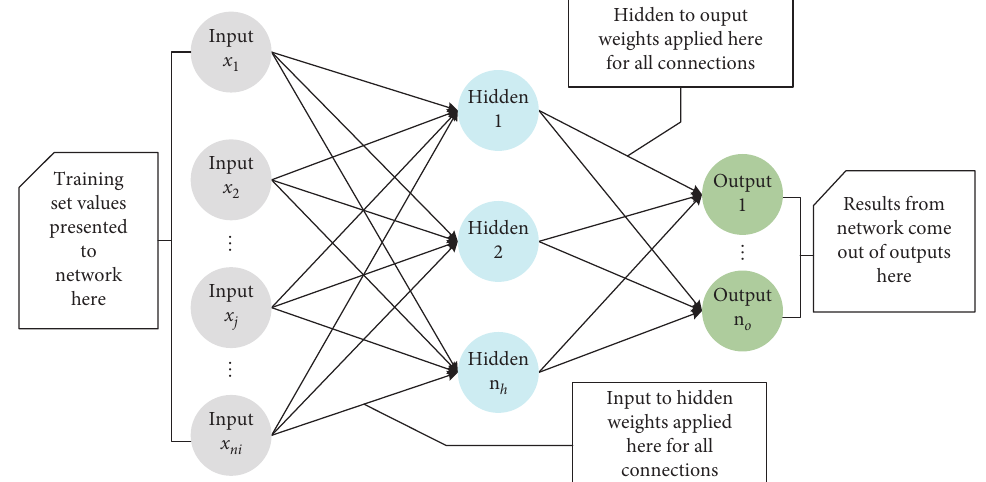
Figure 1: Backpropagation artificial neural network (BP-ANN) topology